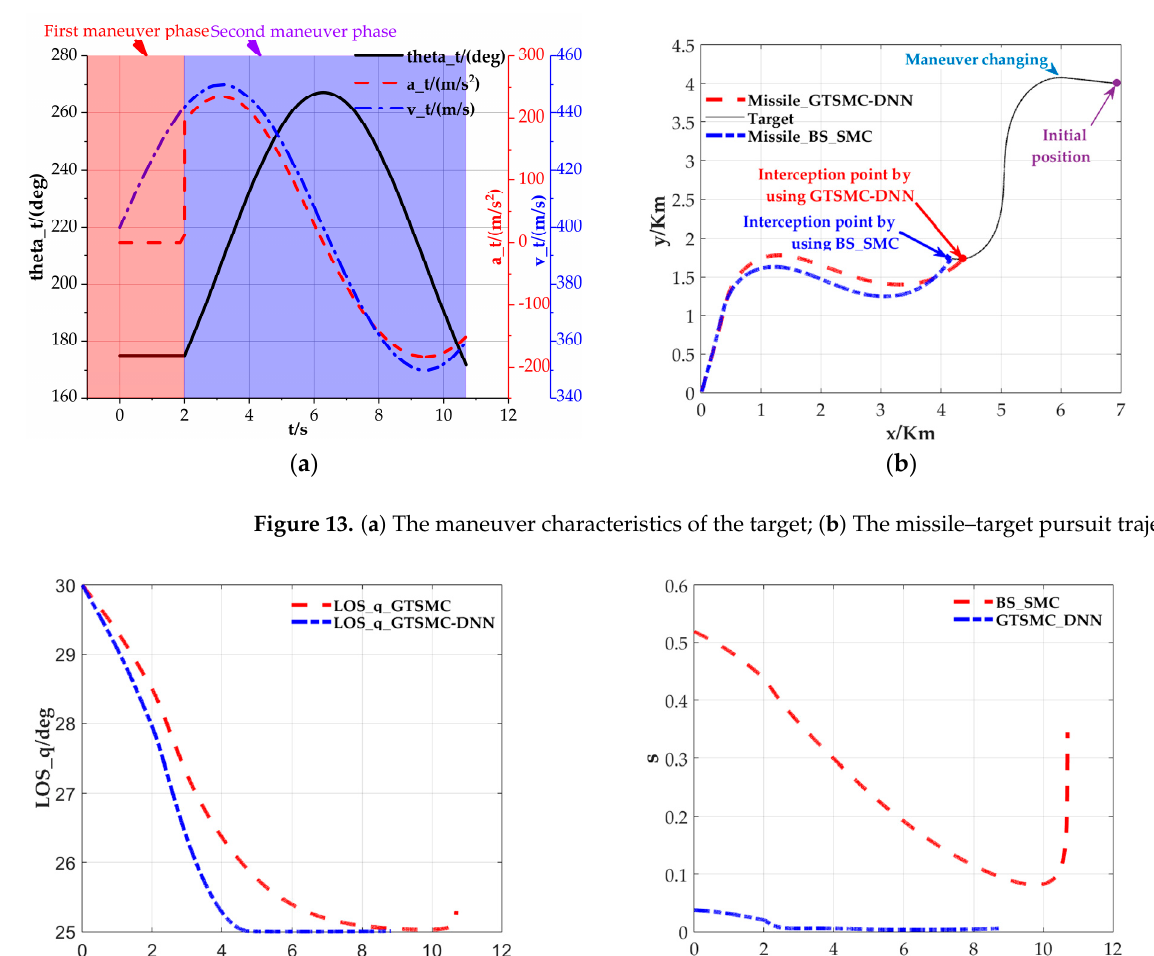
Figure 14. ( a ) System states of LOS angle; ( b ) The sliding mode surface.